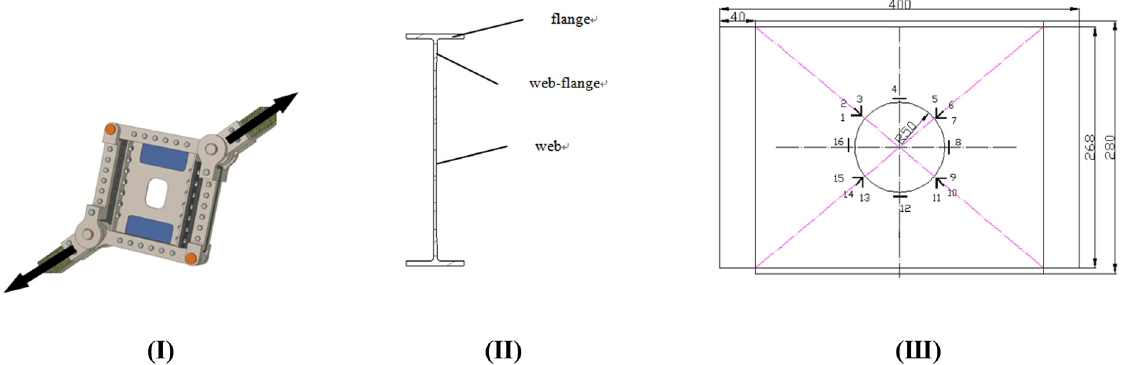
Figure 1: Schematic diagram of the sample - holding section. ( I ) Test loading mode. ( II ) Sample section. ( III ) Strain measurement